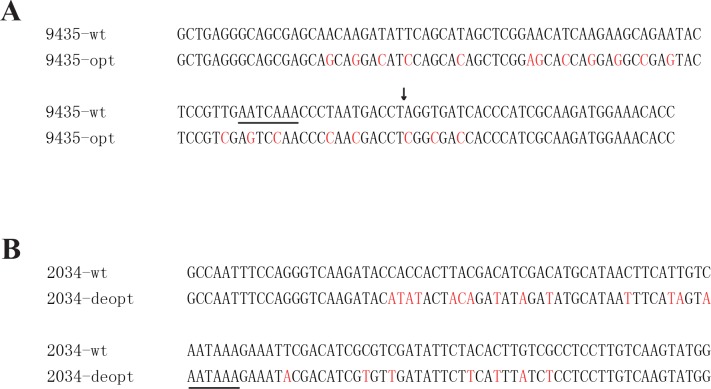
Sequence alignment of NCU09435-wt and NCU09435-opt construct﻿s (A) and ﻿sequence alignment of NCU02034-wt and NCU02034-deopt constructs (B).Nucleotides that are mutated in the optimized NCU09435 gene are shown in red. The arrow indicates the poly(A) site mapped by 2P-seq. The black line in (A) indicates a potential PAS motif present only in the wild-type construct. Nucleotides that are mutated in the de-optimized NCU02034 gene are shown in red. The black line in (B) indicates a potential PAS motif present both in the wild-type and deoptimized construct.